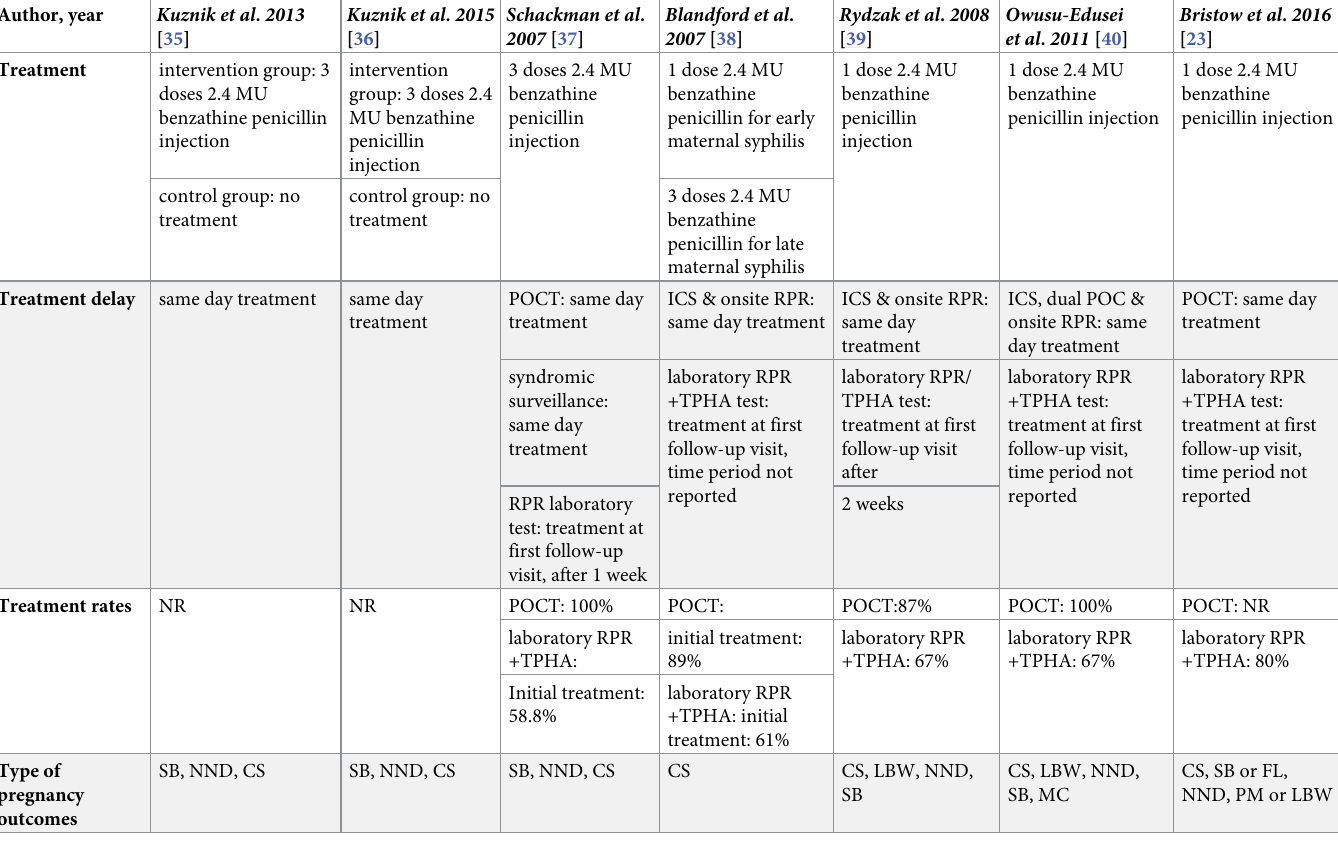
by treponemal POCT, compared to all other screening methods, i.e. no screening, conven- tional laboratory screening, non-treponemal POCT and dual POCT [35–40]. In contrast, one study predicted no difference in adverse pregnancy outcomes for treponemal POCT